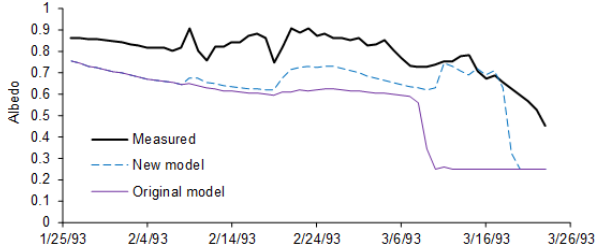
Figure 14. Comparison of measured and modeled albedo at the USU drainage